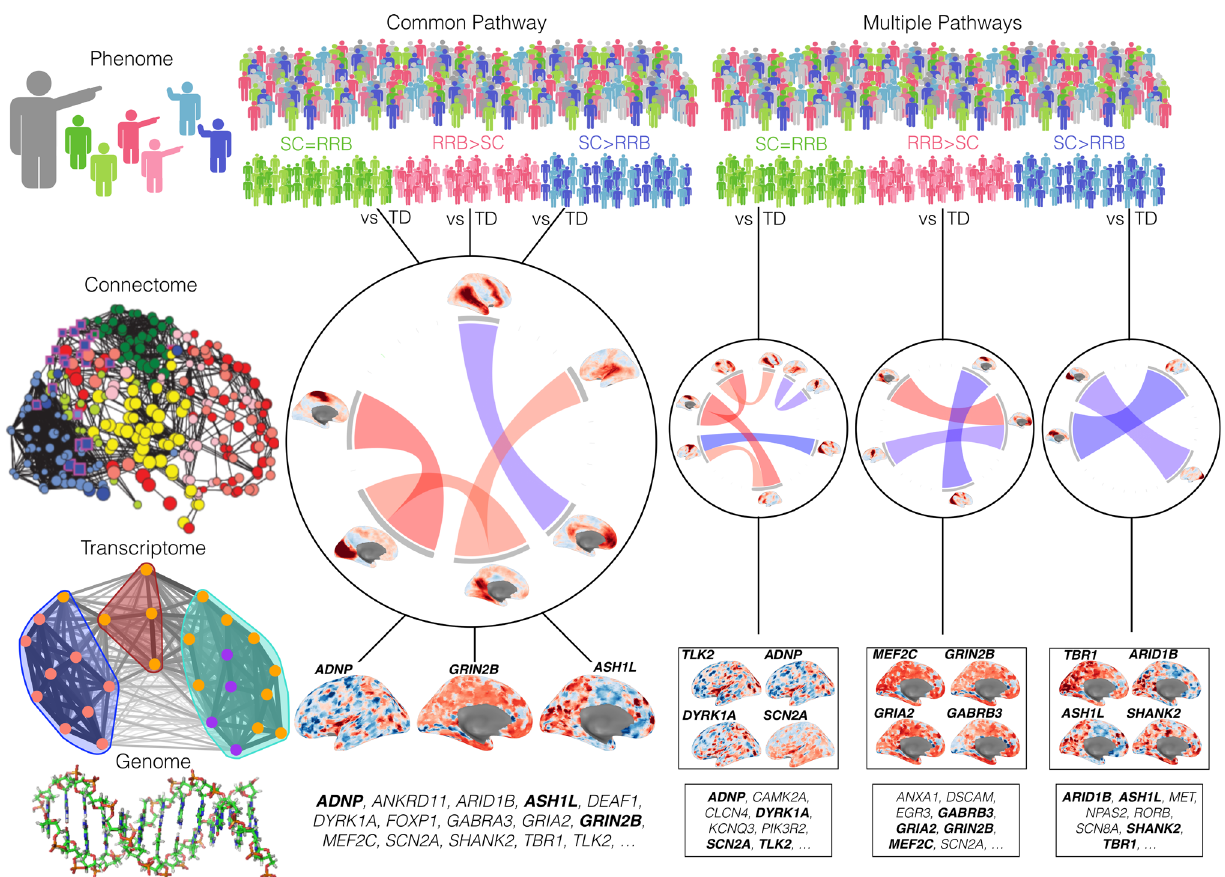
Fig. 1 Approach towards testing common pathway versus multiple pathways explanations behind SC-RRB balance in autism. In this fi gure we depict two alternatives for how SC-RRB balance subtypes (phenome level; SC = RRB, green; RRB > SC, pink; SC > RRB, blue) could be explained at the level of macroscale functional connectome phenotypes measured with rsfMRI (connectome level) and autism-associated functional genomic mechanisms (e.g., transcriptome and genome levels). Columns in this fi gure depict the common pathway (middle) and multiple pathways (right) models. The common pathway model predicts that when each subtype is compared to a typically-developing (TD) comparison group, they converge and share a common difference from TD in affected macroscale rsfMRI functional connectome phenotype. Underpinning this shared connectome phenotype are a myriad of differing functional genomic mechanisms. At the level of the transcriptome, we identify genes linked to macroscale functional networks by identifying genes whose spatial expression pattern across the brain is similar to the spatial topology of the macroscale functional network. This procedure generates a list of genes relevant for such macroscale networks and these lists are then tested for enrichment in autism-association functional genomic mechanisms. The gene list at the genome level represents an example of possible autism-associated genes that may (bold) or may not (non-bold) be linked to macroscale functional networks. In contrast to the common pathway model, the multiple pathways model would highlight that differential connectome phenotypes when compared to TD are unique to each subtype, and that each of these subtype-speci fi c connectome phenotypes is underpinned by a differing set of autism-associated functional genomic